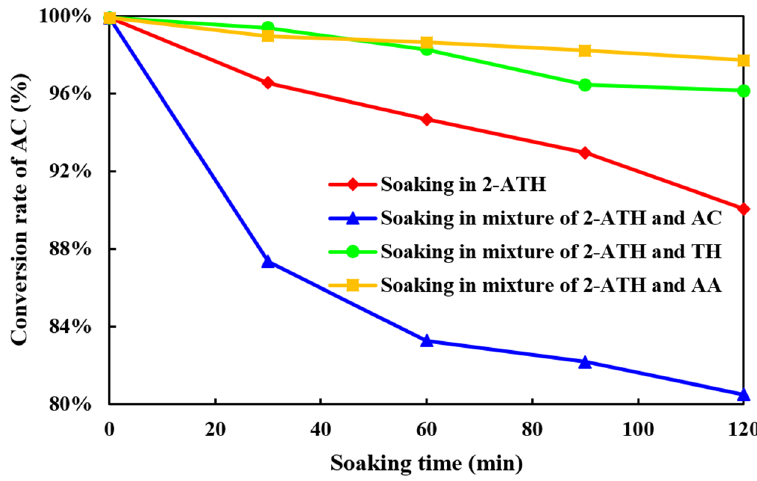
Figure 1. The influence of materials on the inactivation of H-beta (H β ) molecular sieve.